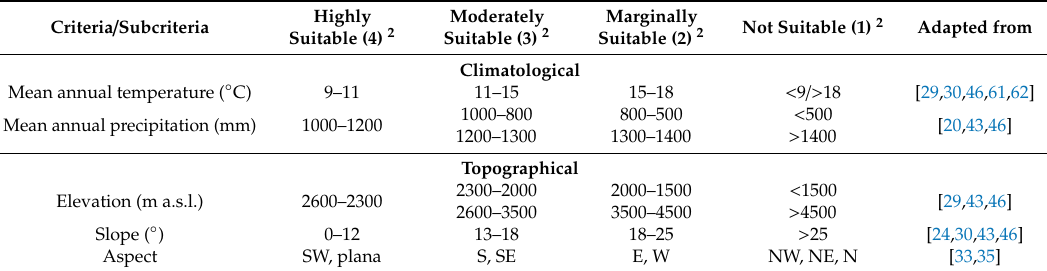
Table 2. Saaty scale for pairwise comparison between the criteria in the AHP.